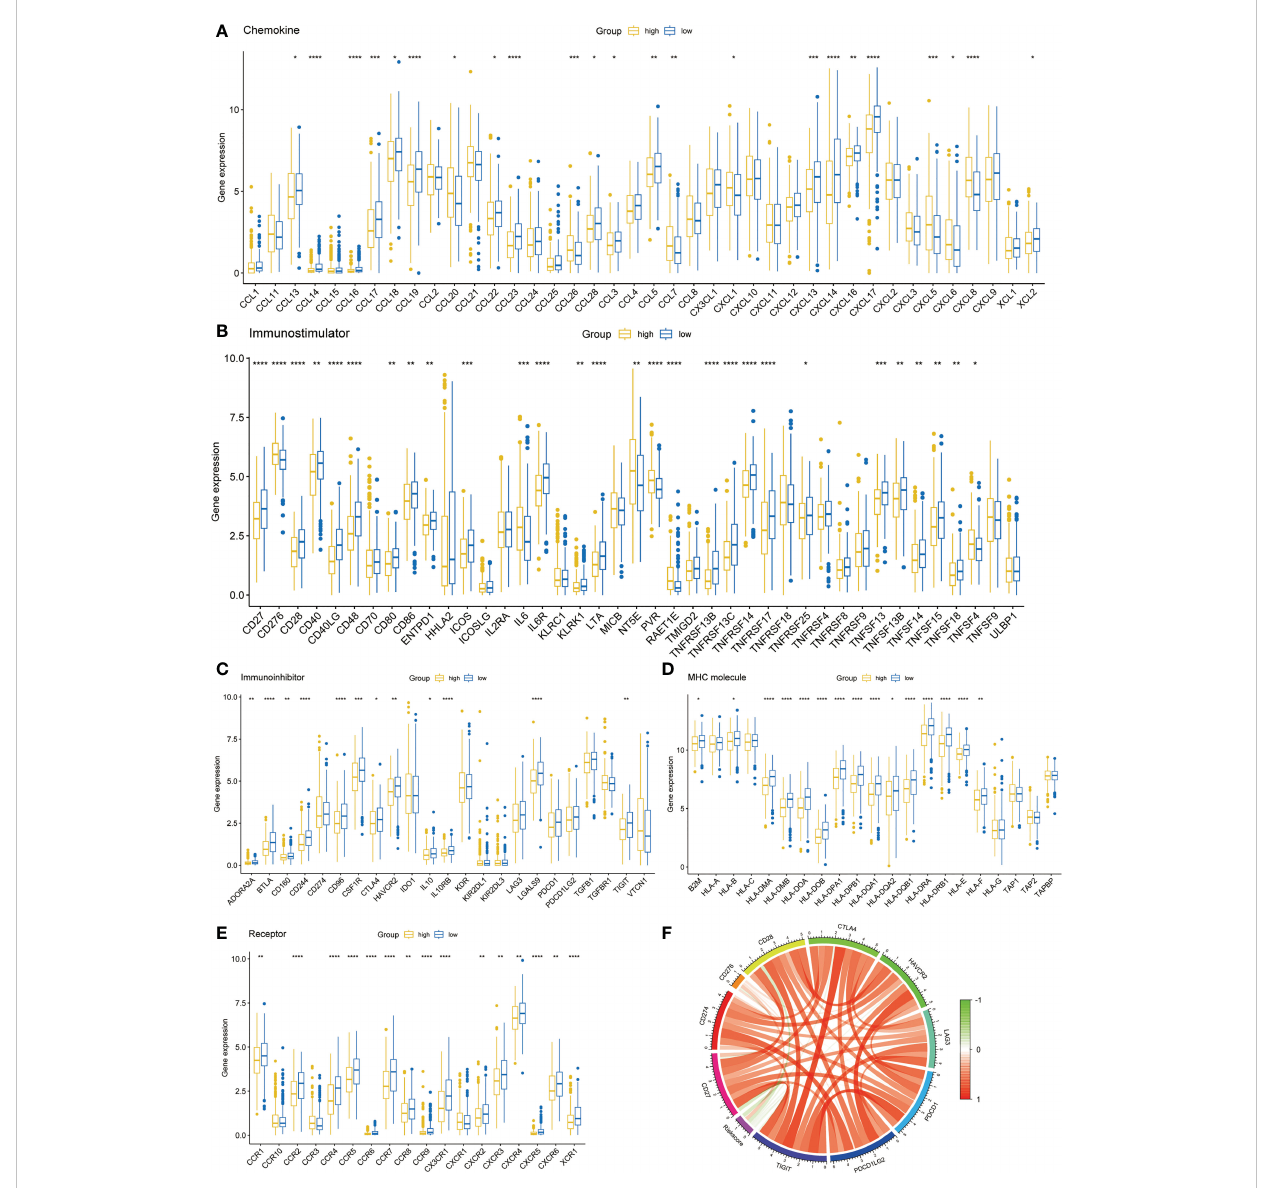
FIGURE 6 Immune-related molecular characteristics. (A) Chemokine. (B) Immunostimulator. (C) Immunoinhibitor. (D) MHC molecule. (E) Receptor. (F) Correlation circle of risk score and immune checkpoints. *p < 0.05, **p < 0.01, ***p < 0.001, ****p <